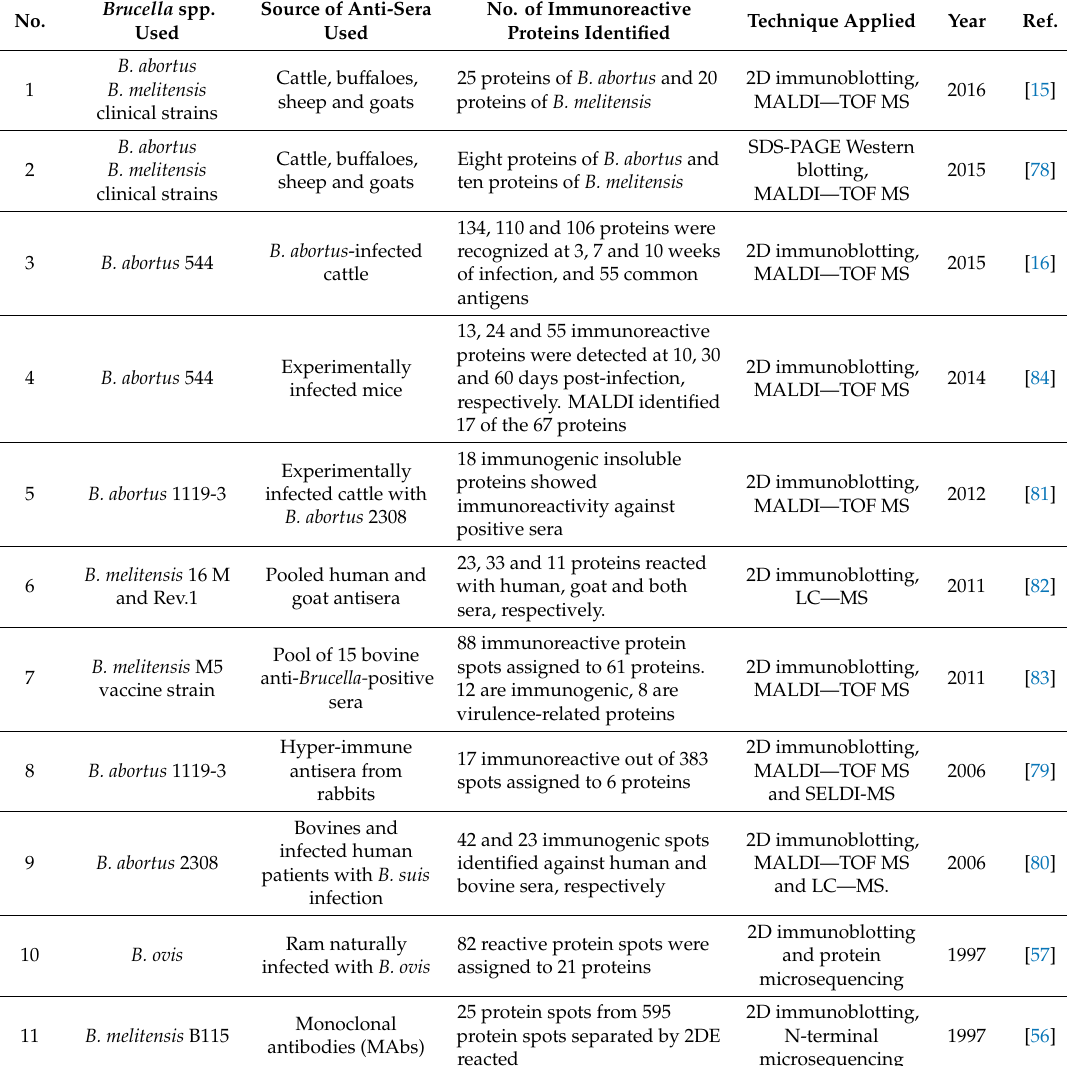
Table 2. List of immunoproteomics studies on brucellae using di ff erent sets of anti- Brucella antisera showing the number of the immunoreactive proteins, the techniques applied and the year of publication.